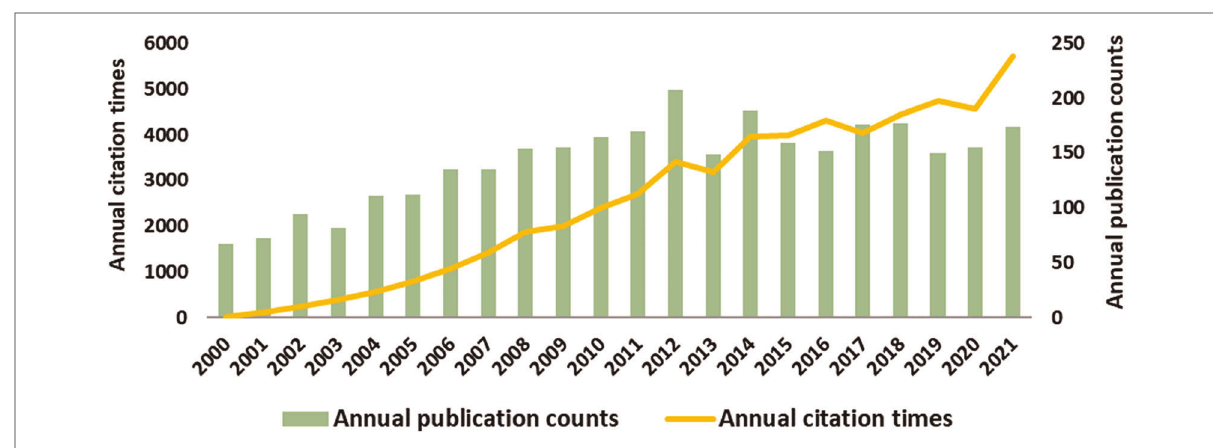
FIGURE 2 Analysis of global research trend of craniomaxillofacial distraction osteogenesis during 2000 –